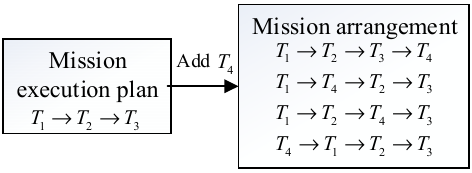
Figure 4. Schematic diagram of matrix arrangement.